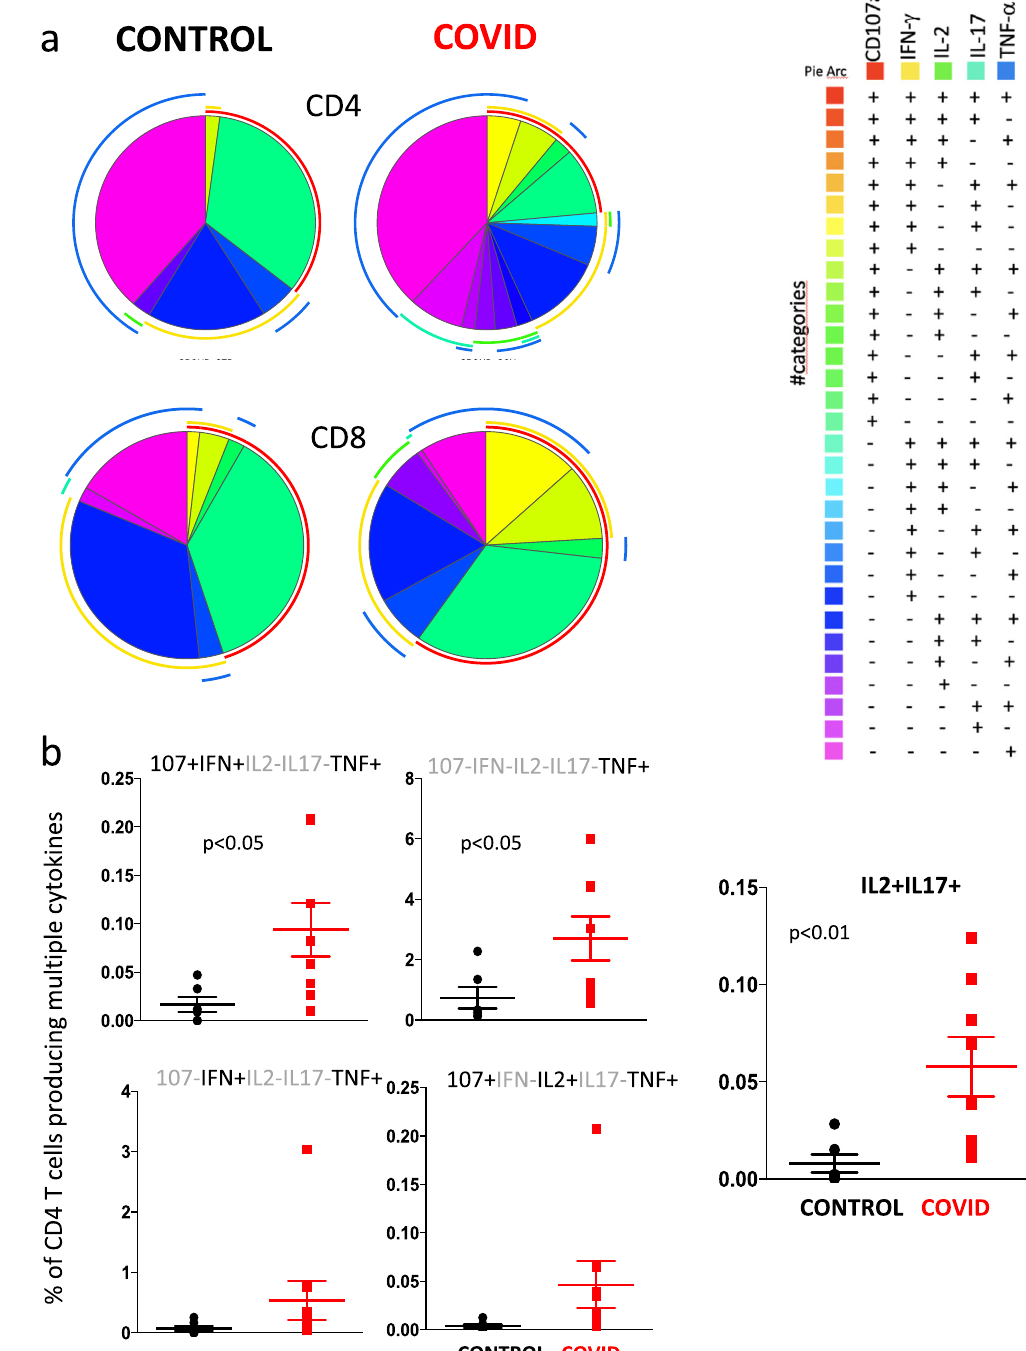
Fig. 9 Polyfunctionality of CD4 + and CD8 + T cells after in vitro stimulation with anti-CD3/28. a Pie charts representing the proportion of responding CD4 + (upper pies) and CD8 + (lower pies) T cells producing different combinations of CD107a, IL-2, IFN- γ , and TNF after anti-CD3/CD28 stimulation in control donors (left; n = 7) and patients (right; n = 11). Frequencies were corrected by background subtraction as determined in non-stimulated controls using SPICE software. Pie arches represent the total production of different cytokines. b Comparison between the production of different combinations of cytokines by CD4 + T cells after in vitro stimulation with anti-CD3/CD28. Data represent individual values from 7 controls and 11 patients, mean (centre bar) ± SEM (upper and lower bars). Statistical analysis by two-sided Mann – Whitney nonparametric test; if not indicated, p value is not signi fi